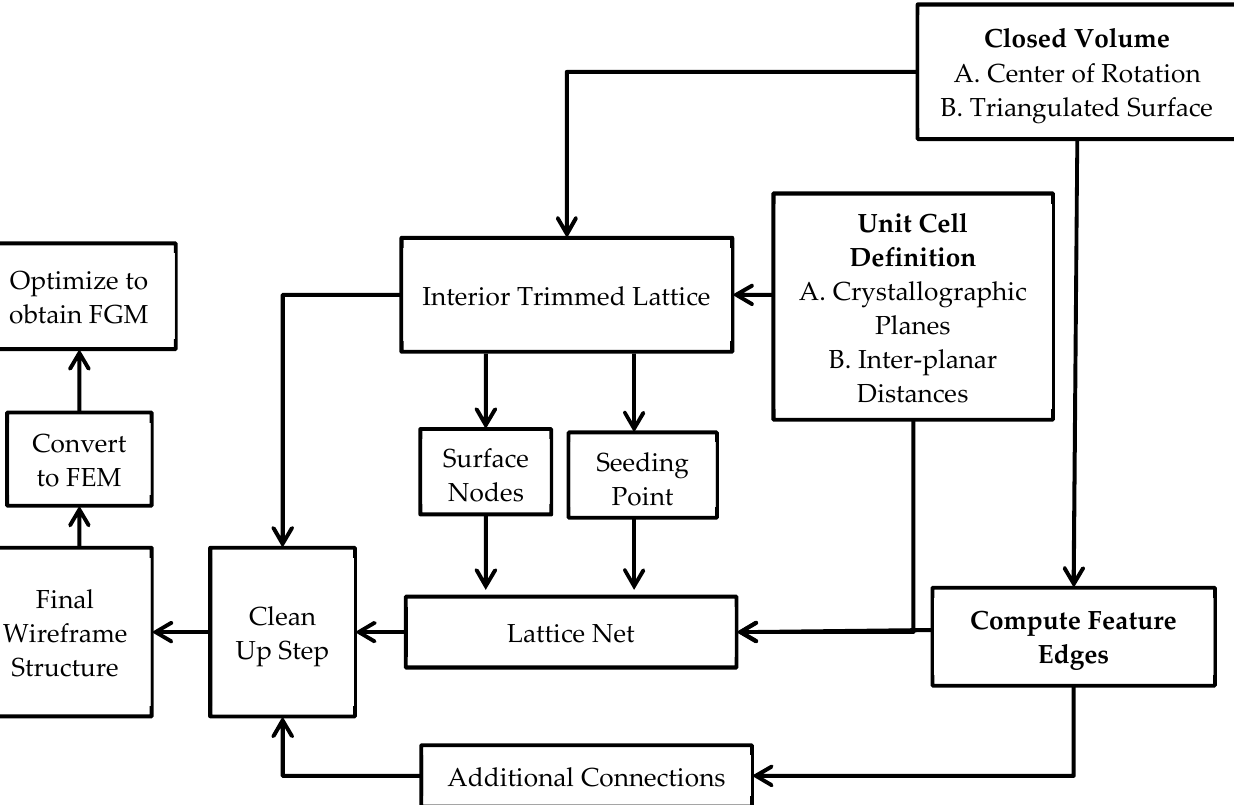
Figure 3. Block diagram of workflow for a wireframe trimmed lattice with a conforming net.